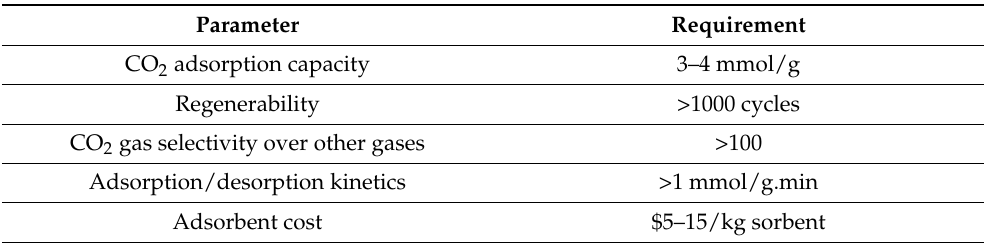
Table 6. Threshold values of criteria for selecting an effective CO 2 adsorbent (Reprinted with permission from refs.